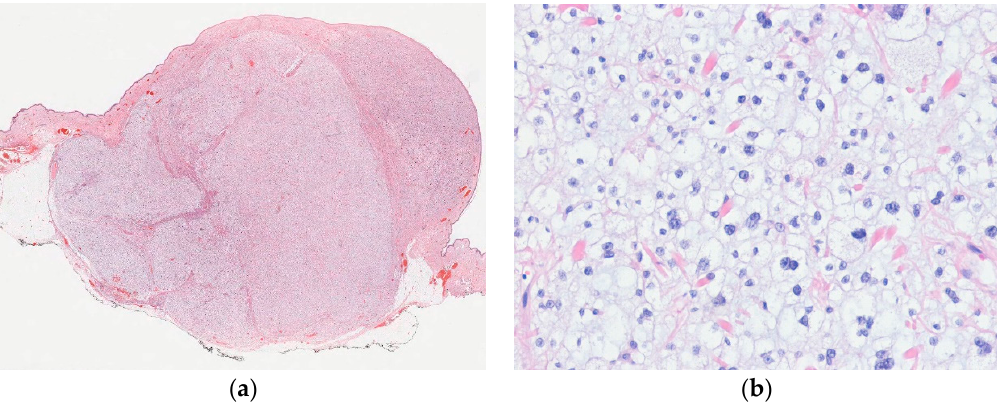
Figure 6. Distinctive dermal clear cell mesenchymal neoplasm. ( a ) Scanning magnification shows a well-circumscribed, solitary tumor in the dermis and subcutaneous tissue; ( b ) The tumor cells have epithelioid or polygonal cells with abundant clear cytoplasm and are arranged in sheet-like pattern (H&E stain, original magnifications 10× ( a ) and 200× ( b